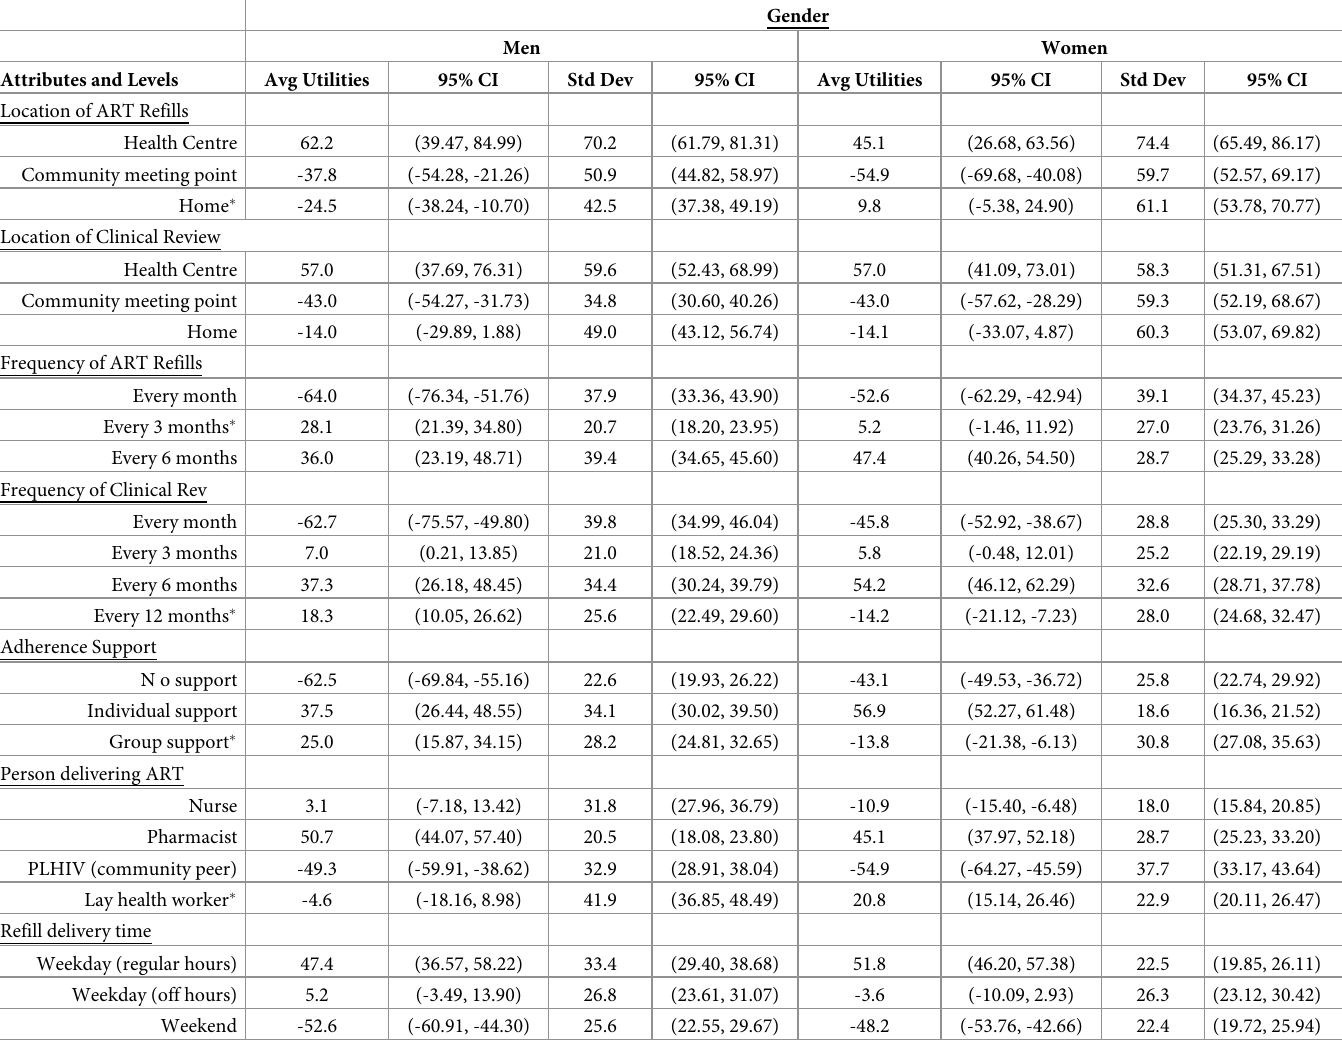
Table 7. Normalized average utilities of all levels by